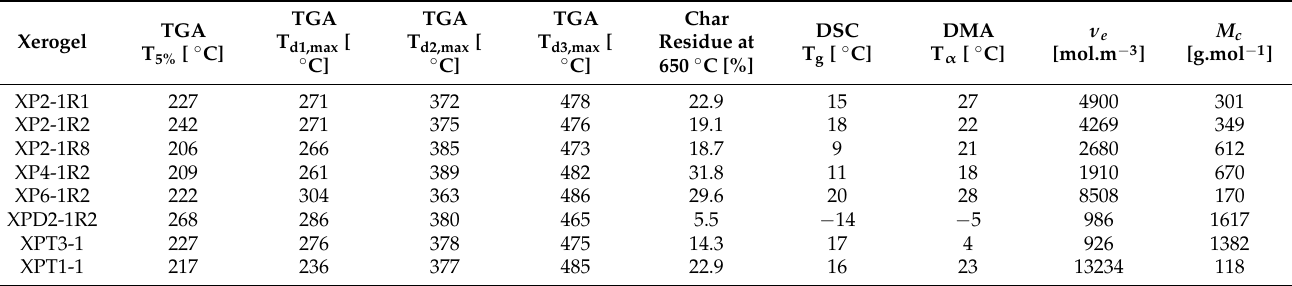
Table 2. Main physico-chemical properties and parameters of the synthesized xerogels.